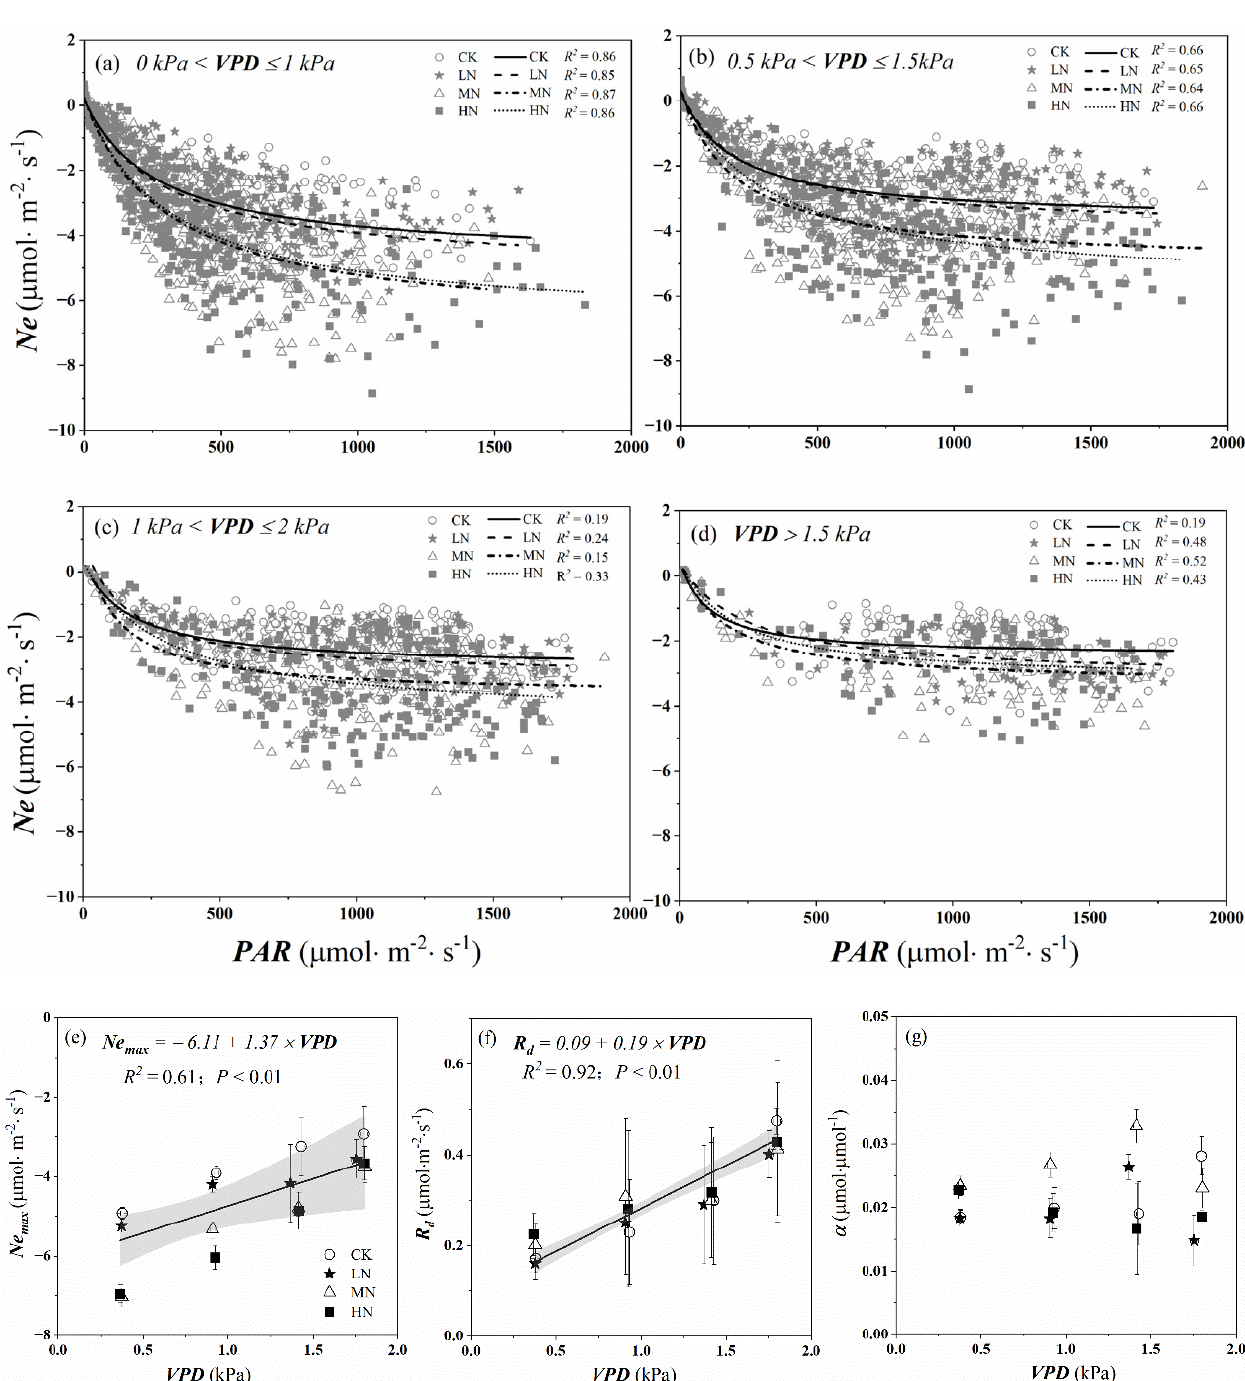
Figure 9. Ne − PAR relations for different VPD ranges (0 kPa < VPD ≤ 1 kPa, 0.5 kPa < VPD ≤ 1.5 kPa, 1 kPa < VPD ≤ 2 kPa and VPD > 1.5 kPa) and nitrogen addition levels ( a – d ) during the growing season. Dots represent hourly daytime Ne values and lines are Michaelis–Menten equation fits (Equation (4)). The solid lines, dashed lines, dot-dash lines, and dotted lines show the Ne − PAR curves under CK (control, no nitrogen addition), LN (low nitrogen addition, 23 kgN · hm − 2 · a − 1 ), MN (medium nitrogen addition, 46 kgN · hm − 2 · a − 1 ), and HN (high nitrogen addition, 69 kgN · hm − 2 · a − 1 ) treatments, respectively. Equation fitting parameters for these months are presented in ( e – g ): maximum net photosynthetic rate of crown ( Ne max ), the daytime respiration of crown ( R d ), and initial quantum efficiency ( α ). The black lines represent the linear regression across all N treatments, and the light grey shading represents the 95% confidence intervals.